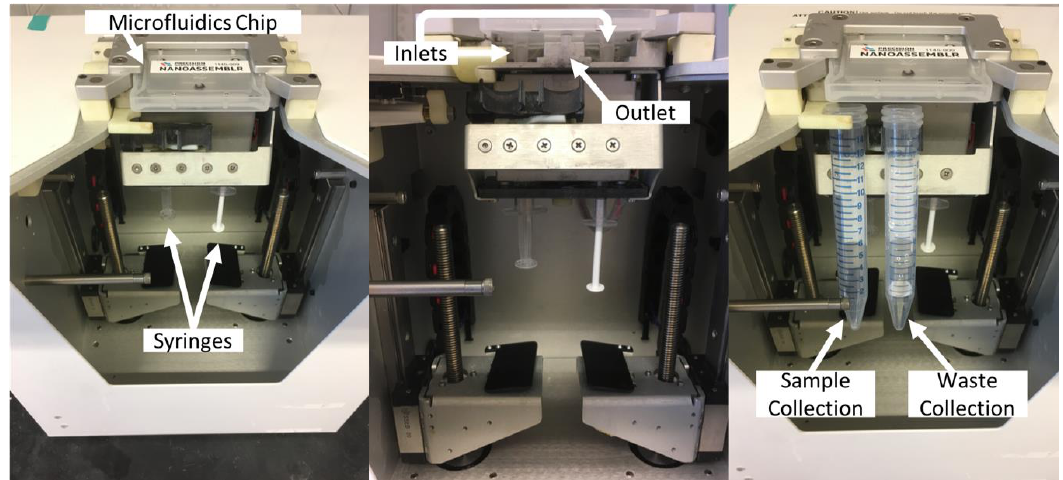
Figure A5. Depiction of the microfluidics device, NanoAssemblr, and its major components.